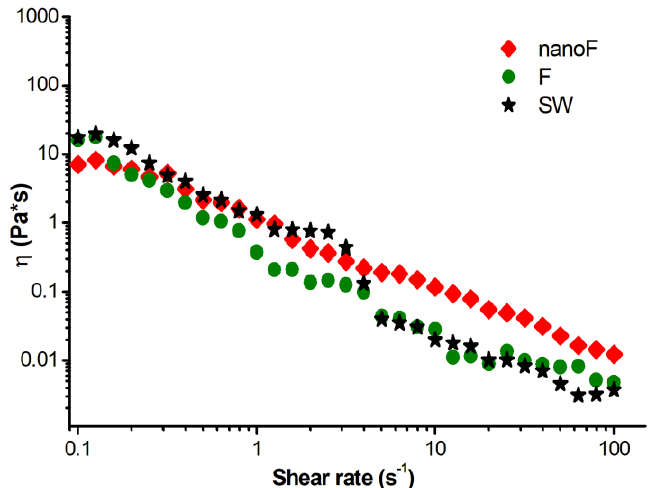
Figure 2. Viscosity of the liquid formulations as a function of the shear rate.